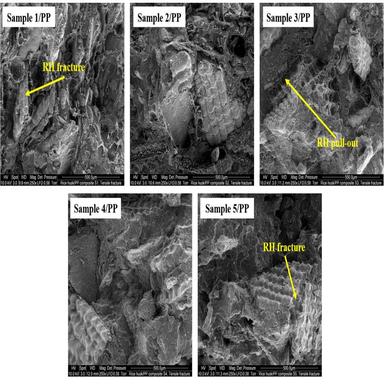
Scanning electron microscopy images of RH/PP composites (tensile fractured surfaces). The micrographs show the manifestation of the RH samples within the PP matrix. Additionally, the images also indicate RH biomass fractures and pull out that facilitated the tensile fracture. (For interpretation of the references to colour in this figure legend, the reader is referred to the web version of this article.)